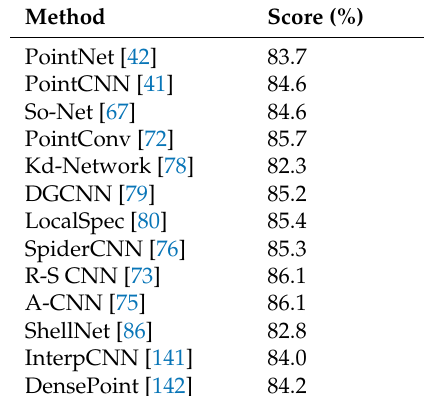
Table 4. Parts segmentation on the ShapeNet part dataset. The score is the mean intersection over union